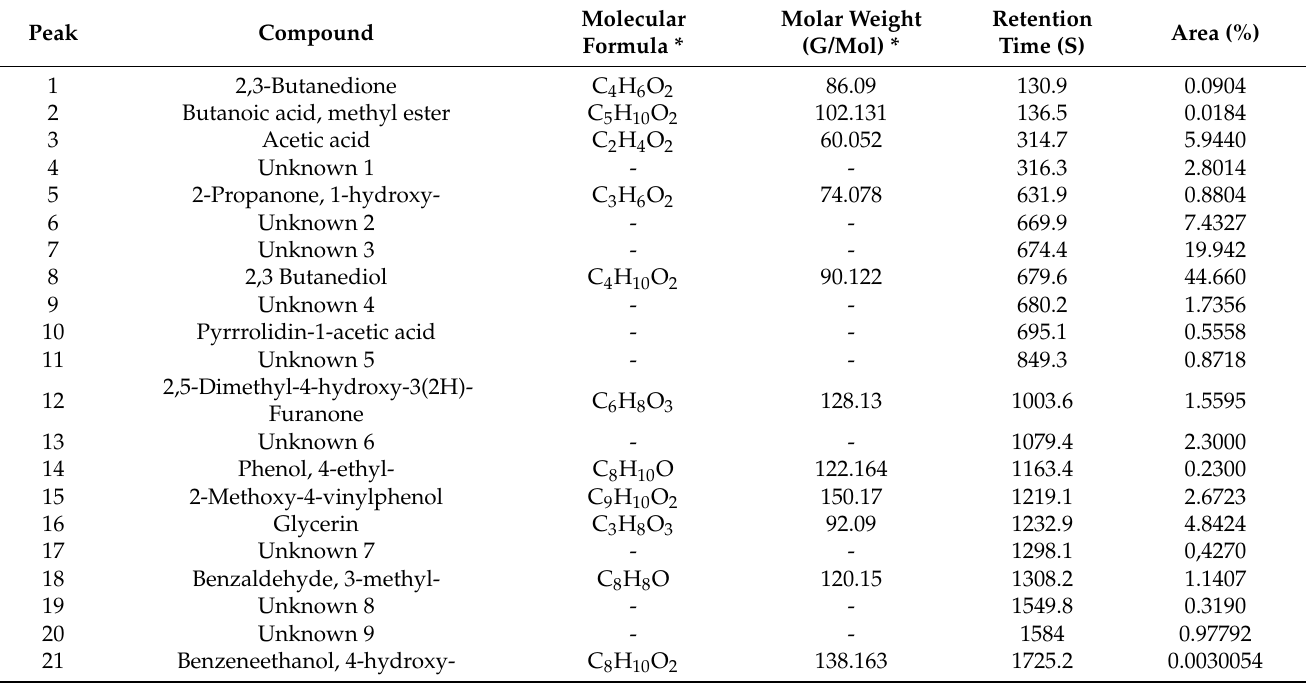
Table 2. Compounds detected in an aqueous extract of herbal mixture used for contraception by traditional health practitioners in Ngaka Modiri Molema District Municipality, South